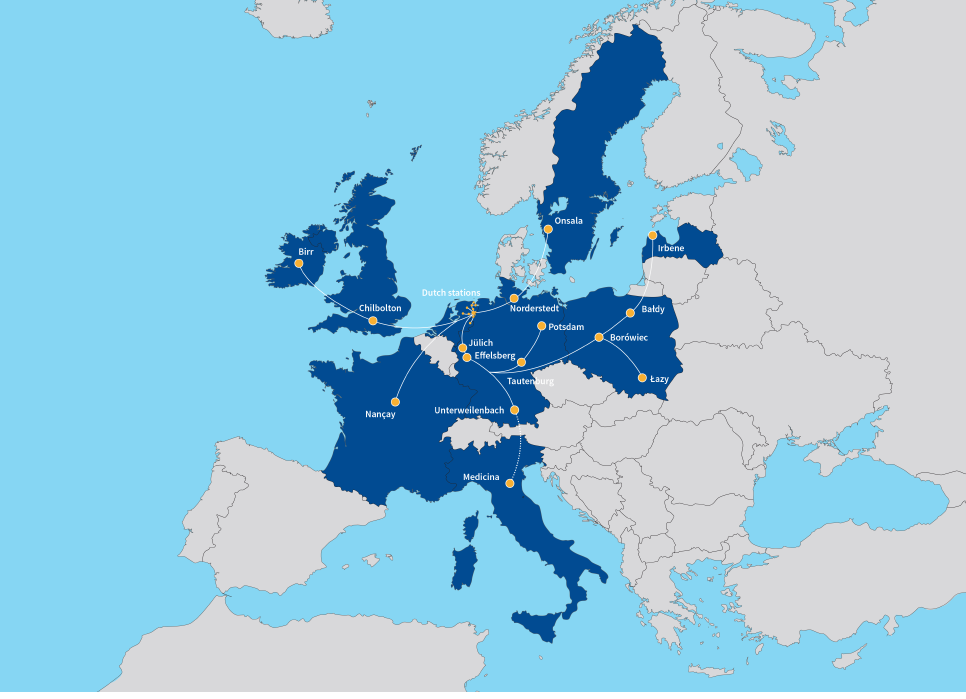
Figure 1. Existing and planned LOFAR stations. Credit: ASTRON.